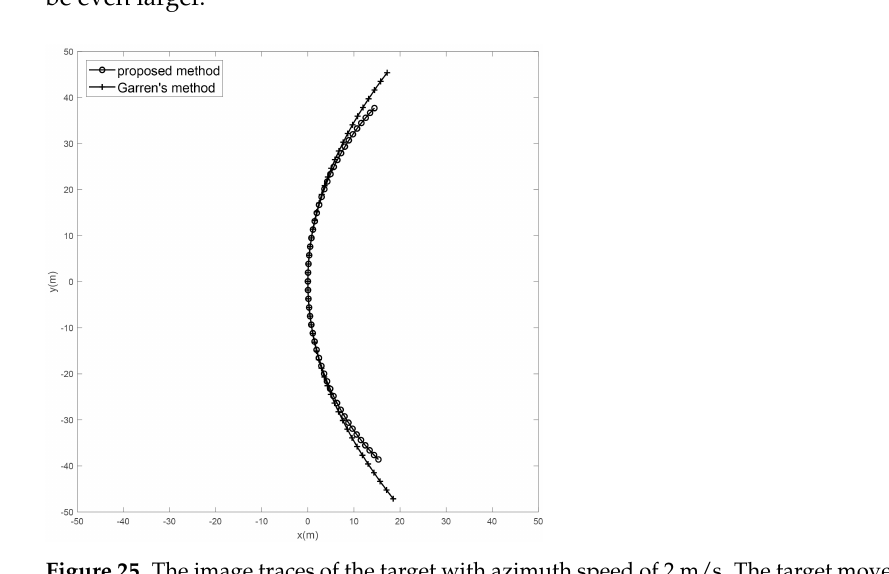
Figure 25. The image traces of the target with azimuth speed of 2 m/s. The target moves from bottom to top.